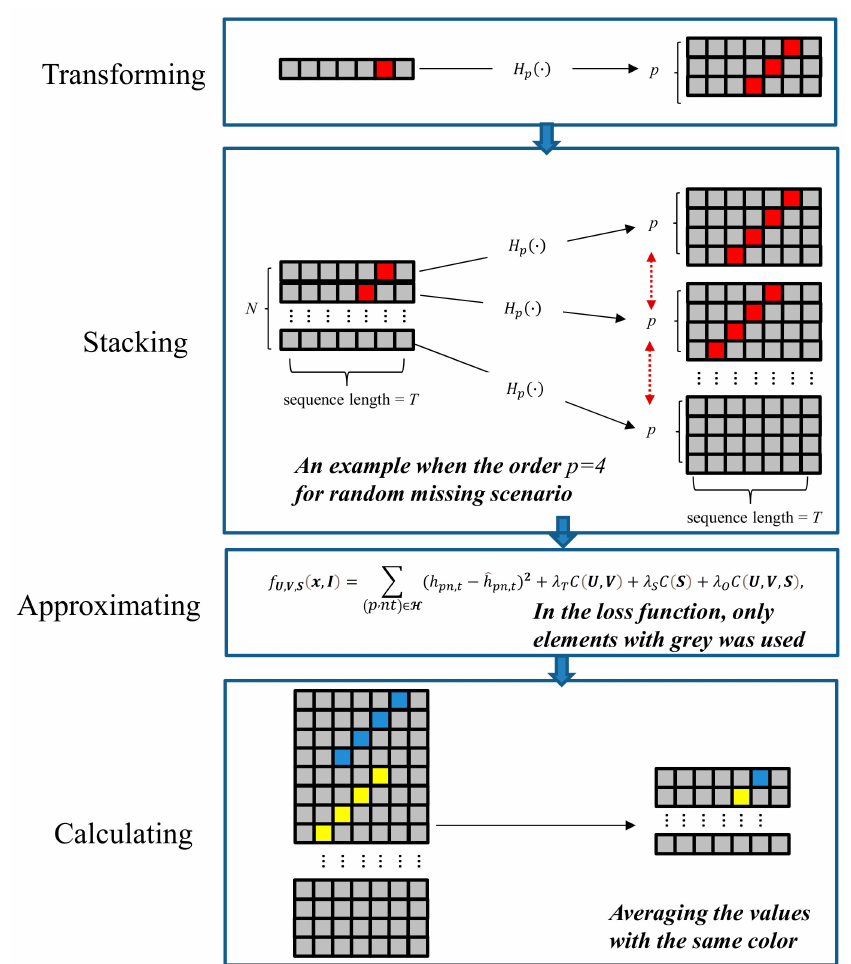
Figure 4. Framework of the proposed